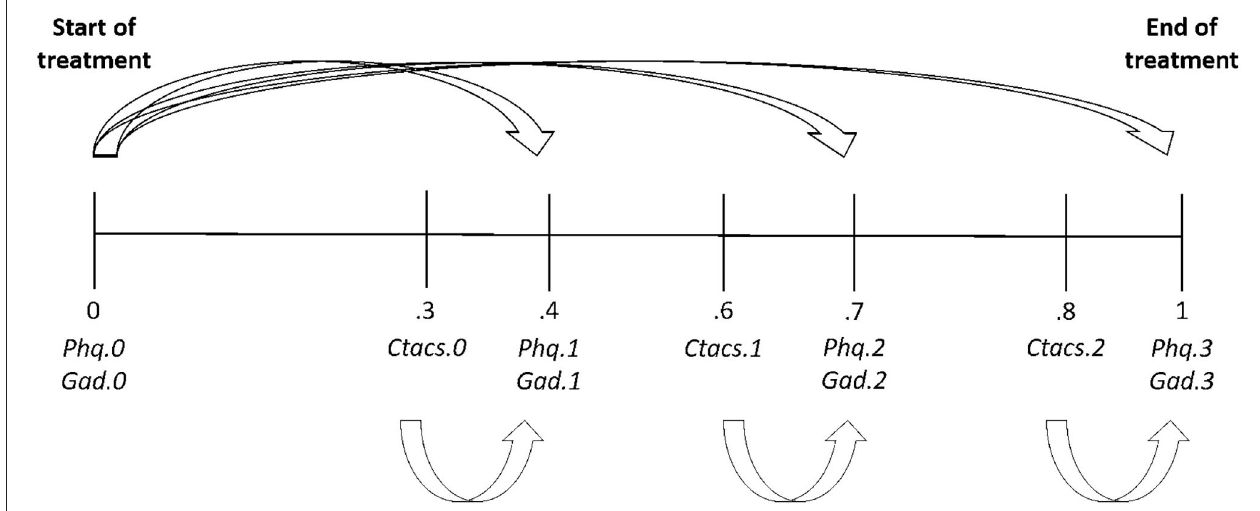
FIGURE 1 | Generic path diagram displaying the average relative positions of measurement occasions in the course of treatment and the proposed associations between competence and therapy outcome